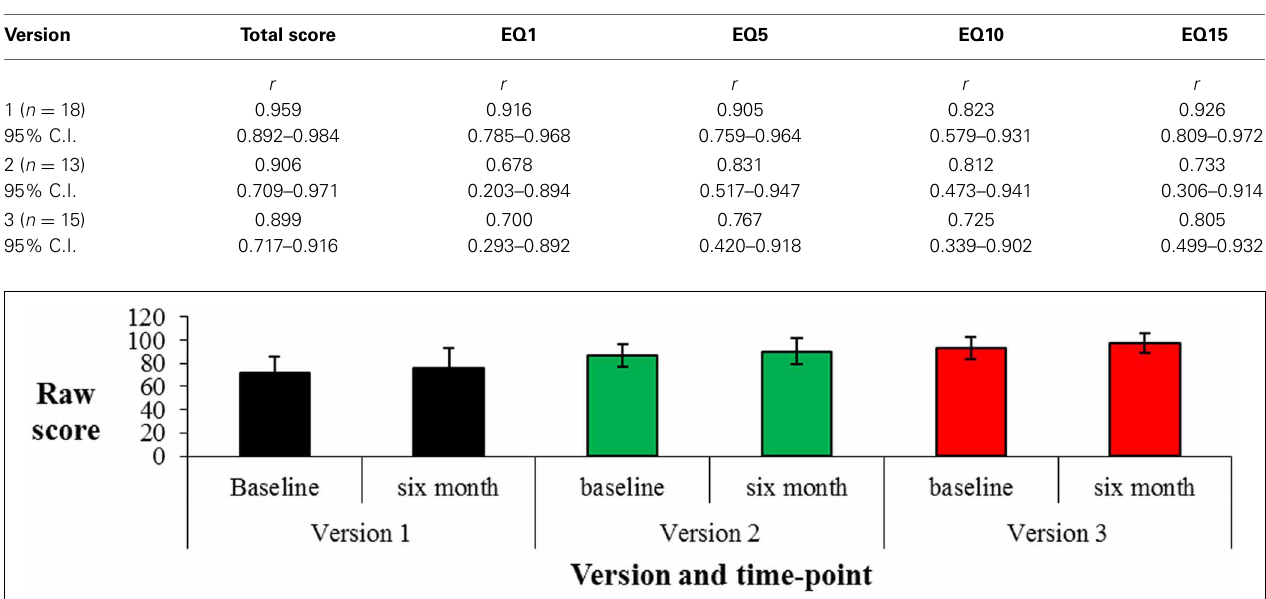
Table 3 | Pearson product-moment correlations ( r ) between baseline and 6 month follow-up.